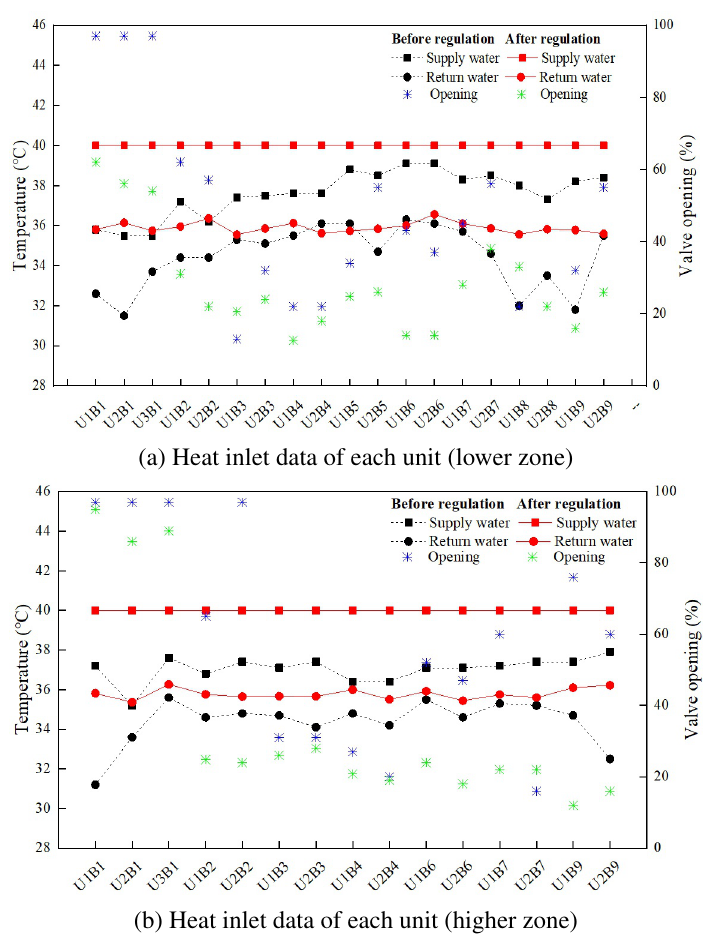
Fig. 10 Pre-regulation and post-regulation data curves.